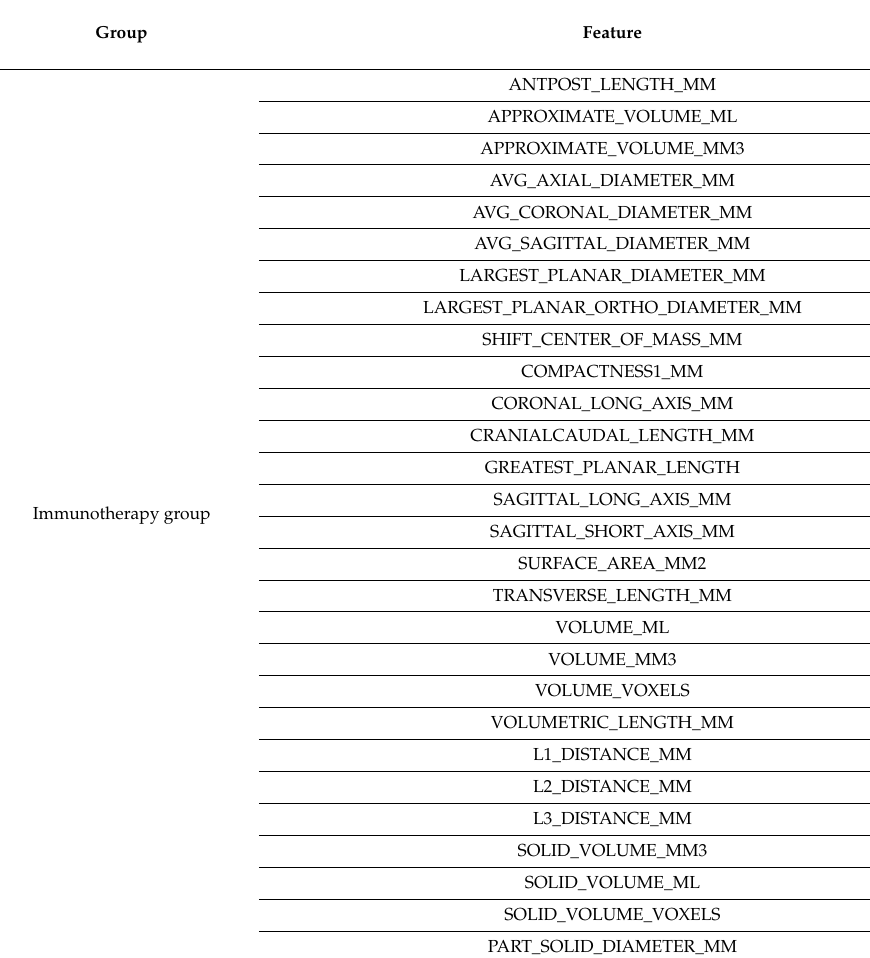
Table 5. Median value and range for textural features significant for stratifying the patients into two groups based on median cutoff of PFS time (short and long time). Group Feature Feature Type